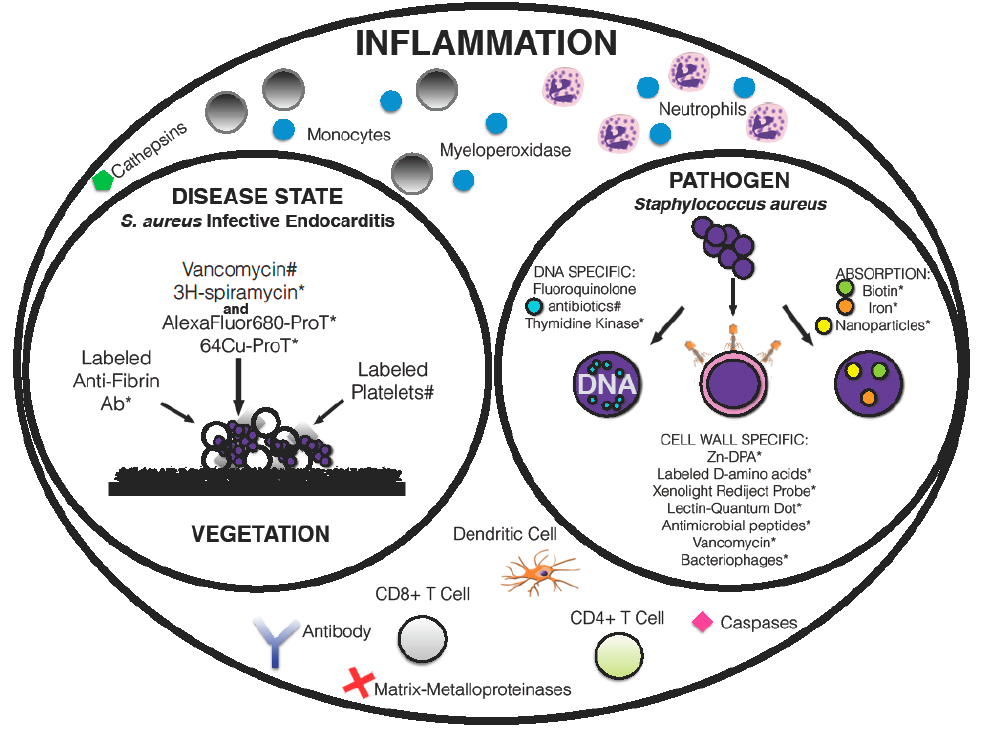
Figure 1. Illustrated within each circle “Inflammation,” “Disease State,” and “Pathogen” are markers that can be utilized as molecular targets in the diagnosis of infection. The identification of general inflammatory markers, depicted in the “Inflammation” circle, indicate the inflammation surrounding an infection, but increased specificity of diagnosis can be gained by focusing on targets associated with a disease state or pathogen. Endocarditis and Staphylococcus aureus are depicted here as representative of a disease state and associated pathogen of interest, respectively, with current pre-clinical (*) or clinical (#) applications